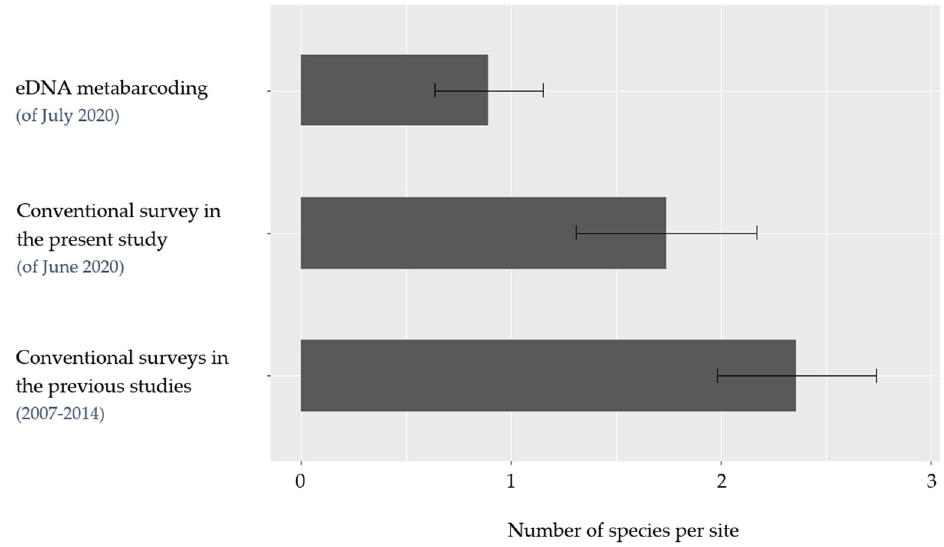
Figure 3. The average number of species detected per site per survey method. Bars indicate the average number of species detected per site ( x -axis) by eDNA metabarcoding and conventional survey methods in the present and previous studies ( y -axis) [25,26]. Lines with whiskers indicate 95% confidence